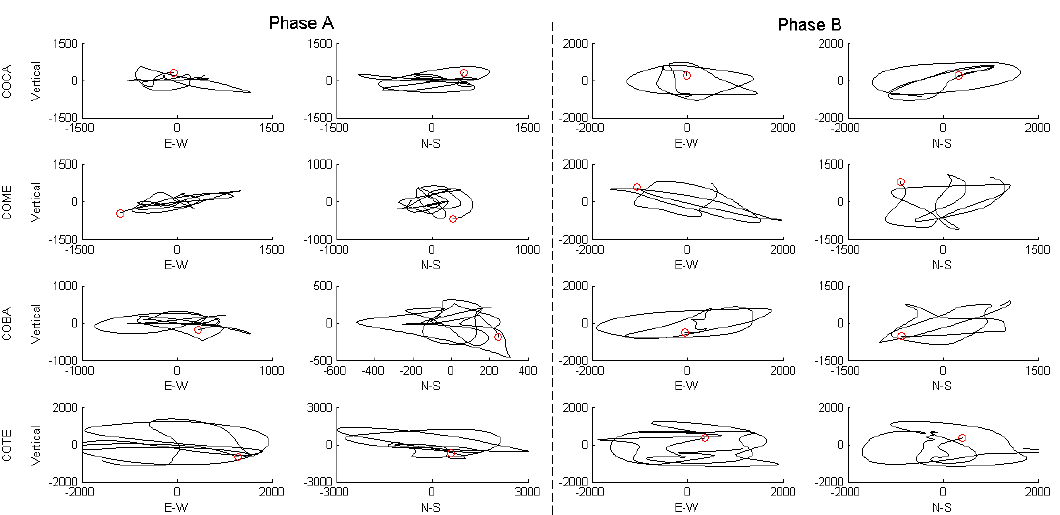
Fig. 9. Example of particle motions at COCA, COME, COBA and COTE for a sample of 16 seconds of Phase A (09/12/2005 13:00, 30/11/2005 03:00 for COTE) and Phase B (14/02/2006 13:00, 22/01/2006 03:00 for COTE). The motion is projected into EW-Z and NS-Z planes. Red circles indicate the initial point. Units are counts. Clockwise motion dominates Phase B. In Phase A, the motion is scattered and a stable oscillation pattern does not appear. Clockwise motion is occasionally detectable, especially at the stations farthest from the crater; it is visible in the plots as trajectories escaping from the core of the motion.